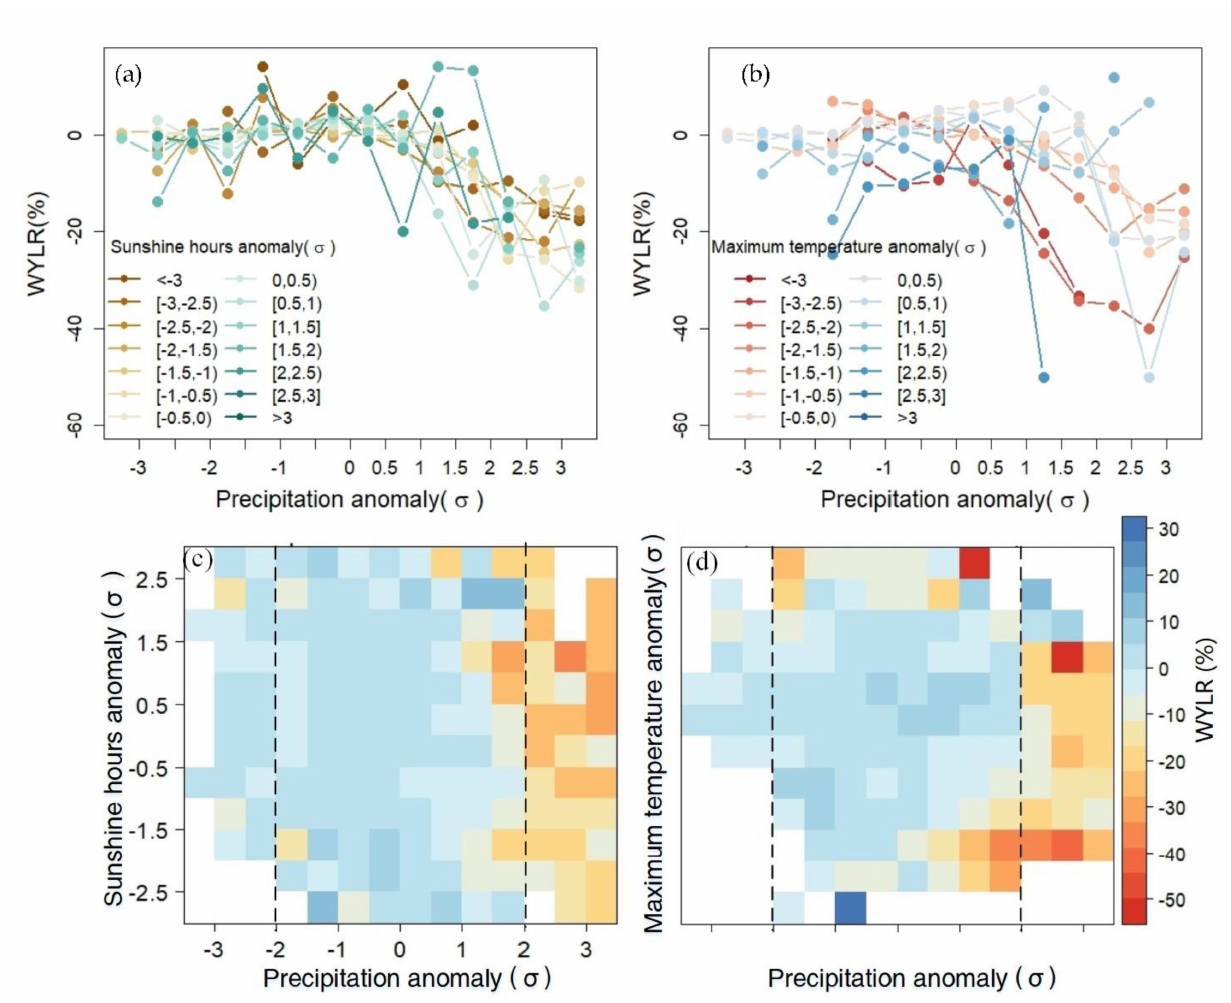
Figure 5. Disentangling sunshine hours and maximum temperature limitation effects from precipita- tion. Precipitation versus WYLR, binned by sunshine hours ( a ) and maximum temperature anomaly ( b ), respectively. Each circle represents the averaged WYLR within each bin of sunshine hours and maximum temperature anomaly. Average WYLR in each bin of sunshine hours ( c ) and maximum temperature ( d ). The dashed line means the threshold value of extreme